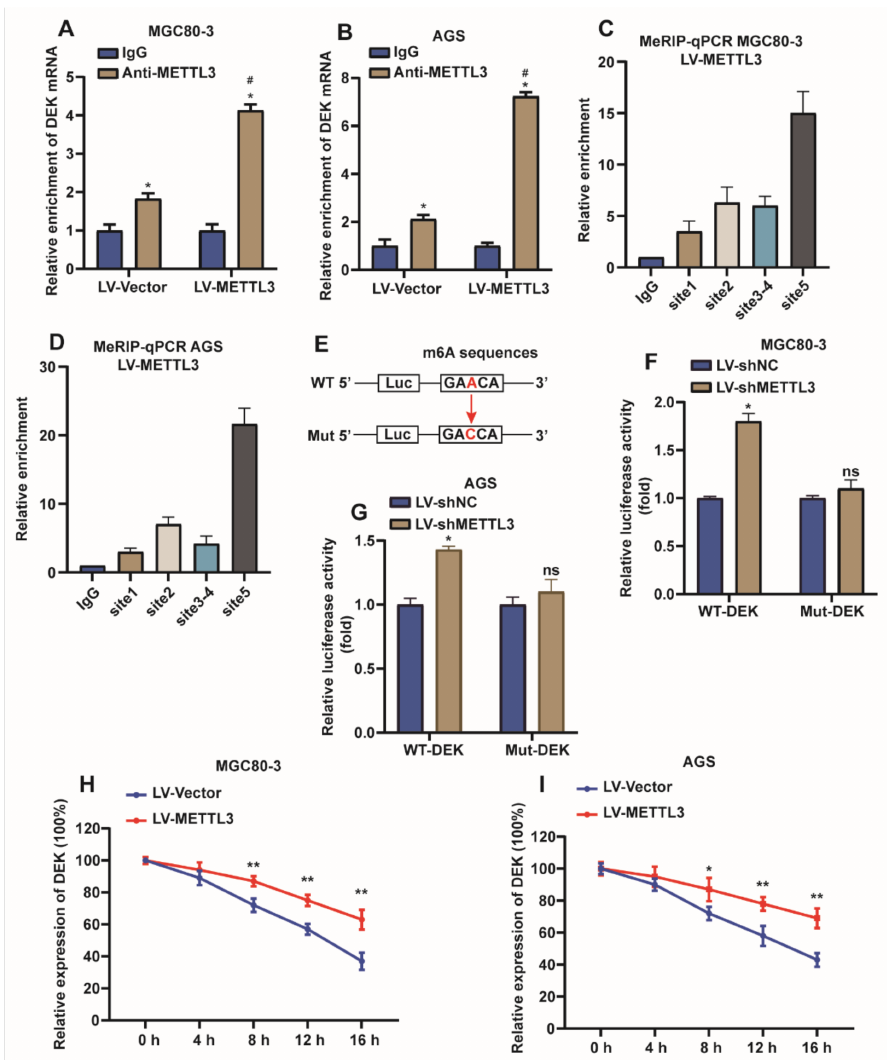
Figure 4. METTL3 stabilize DEK mRNA via m6A modification in GC. ( A , B ) RIP-qPCR assays were used to detect the enrichment of METTL3 binding DEK in MGC80-3 and AGS cells (*, vs. IgG, p < 0.05; #, vs. anti-METTL3 in NC group, p < 0.05). ( C , D ) MeRIP-qPCR assay assessing m6A enrichment of DEK mRNA when METTL3 was overexpressed in MGC80-3 and AGS cells ( n = 3, **: p < 0.01). ( E ) Luciferase reporters of wild type and mutation DEK were constructed. ( F , G ) Mutation of the m6A recognition sequence or knockdown of METTL3 increased luciferase activity in MGC80-3 and AGS cells ( n = 3, *: p < 0.05). ( H , I ) METTL3 was overexpressed in MGC80-3 and AGS cells, and the half-life of DEK mRNA was detected by qPCR ( n = 3, **: p <